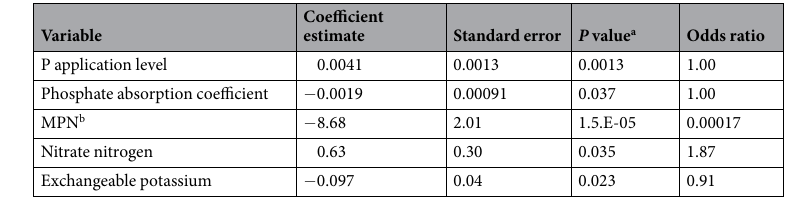
Table 3. Effect size of biotic and abiotic factors on the read abundance of R-10-type OTUs estimated by logistic regression with a random effect model. a Neyman-Pearson test. b Most probable numbers of AM fungal